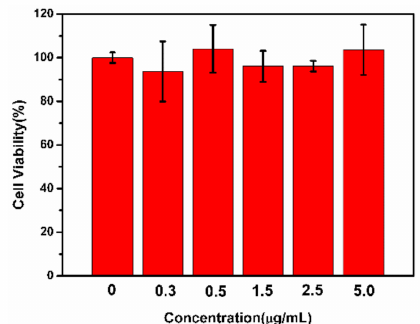
Figure 6. MTT based cytotoxicity assay of Hela cells after 24 h incubation with di ff erent concentrations of Pdots-PPF (0, 0.3, 0.5, 1.5, 2.5, and 5.0 µ g · mL − 1 ) (mean ± SD, n = 3).